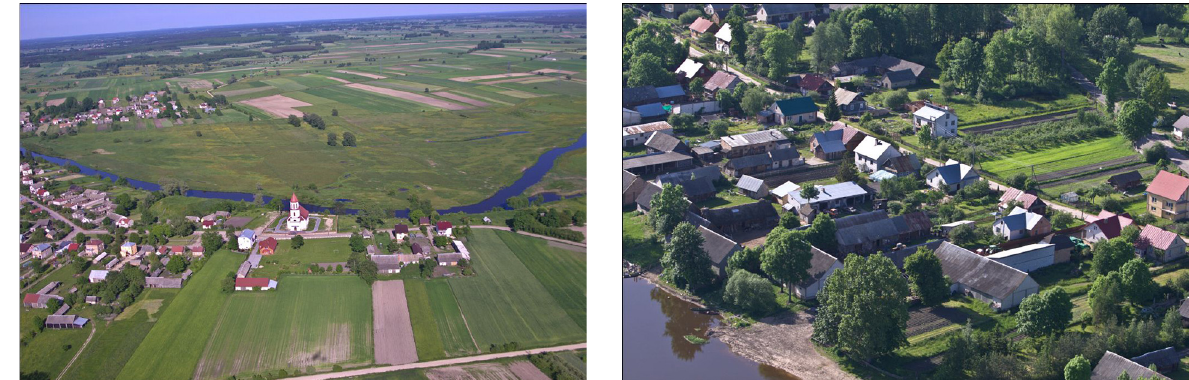
fig. 6a–b. The “village” of Pawłowice (Silesia, southern Poland). Source: the authors.